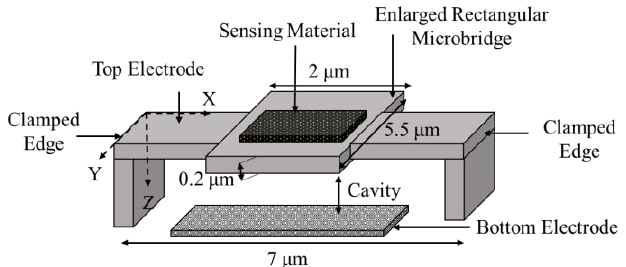
Figure 14. Schematic view of an enlarged rectangular microbridge structure (image not to scale).